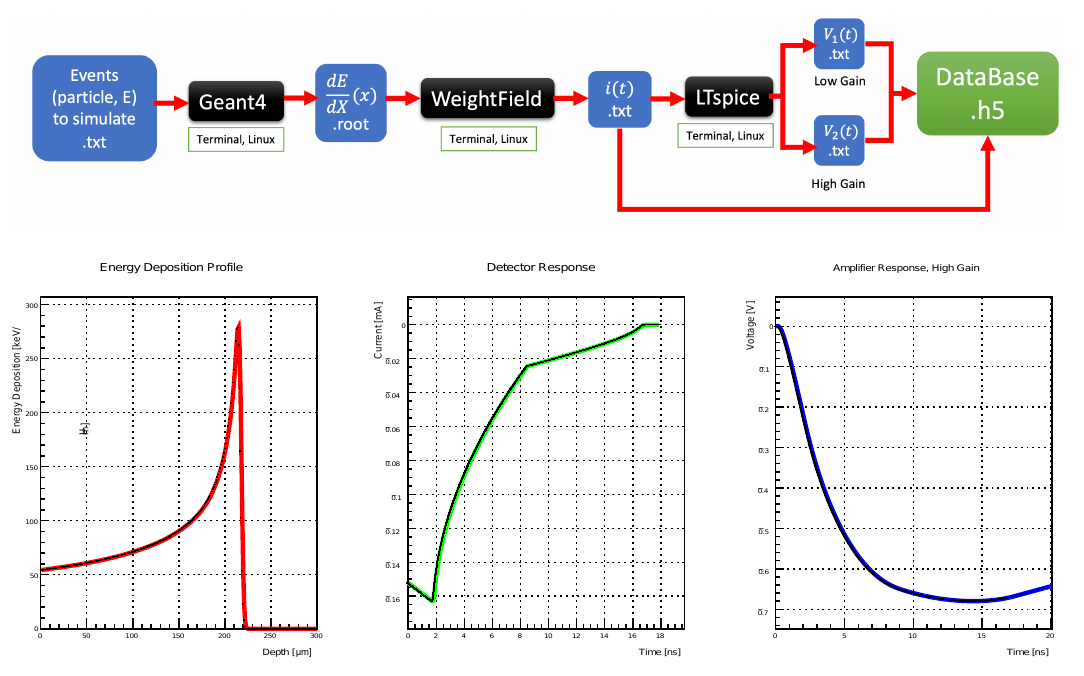
Figure 3. Simulation chain and simulation output examples; from left to right: energy deposition ( x ) ); detector response (current pulse (i(t)) in Weightfield2; amplifier profile simulated in GEANT4 ( dE dx (high-gain) output (voltage pulse V (t)) in